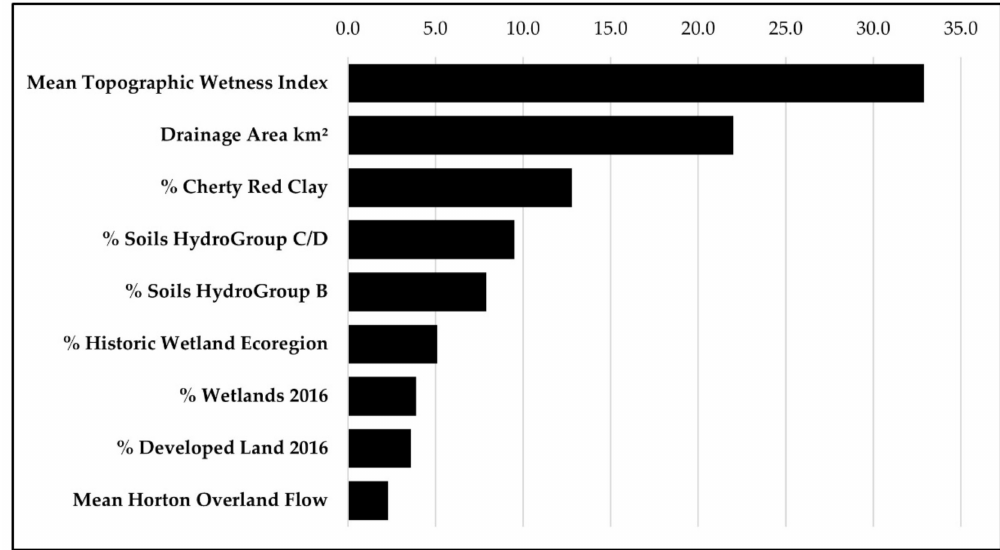
Figure 9. The % I contribution to variance in species richness determined by hierarchical partitioning. Examining Z-scores indicated that mean TWI, area km 2 , and % cherty red clay, each explained a significant percentage of variance, with Z -scores over the 95% confidence limit (Figure 10).